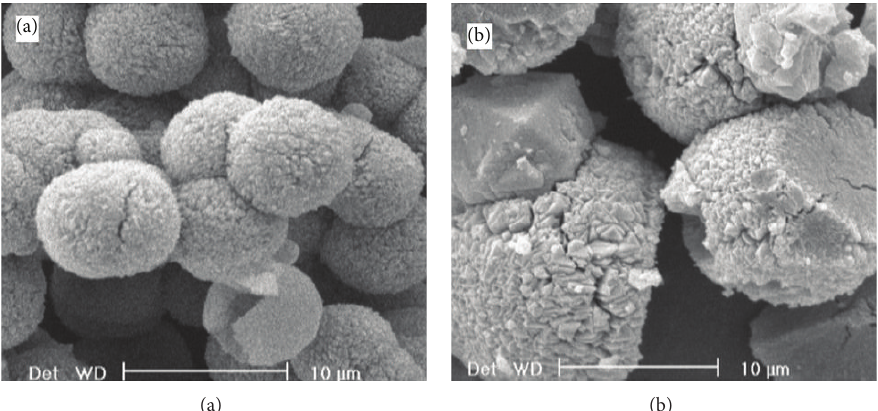
Figure 5: SEM images of synthesized zeolites from initial synthetic gel compositions with Si/Al mole ratios of (a) 15 and (b) 30.